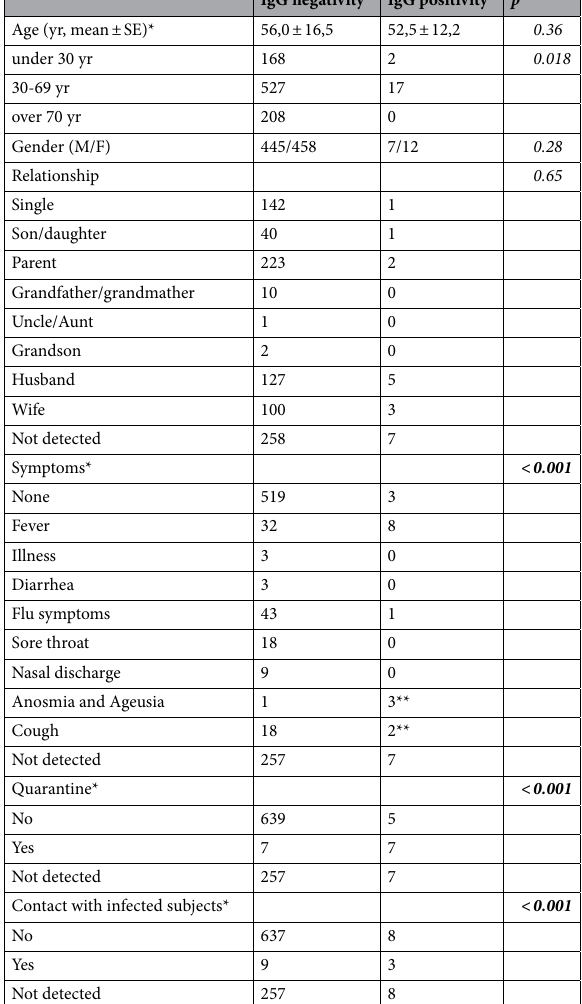
Table 2. Characteristics of the subjects grouped by IgG positivity and IgG negativity, and p -values of statistical comparison between groups (bold values are significant). **Fever